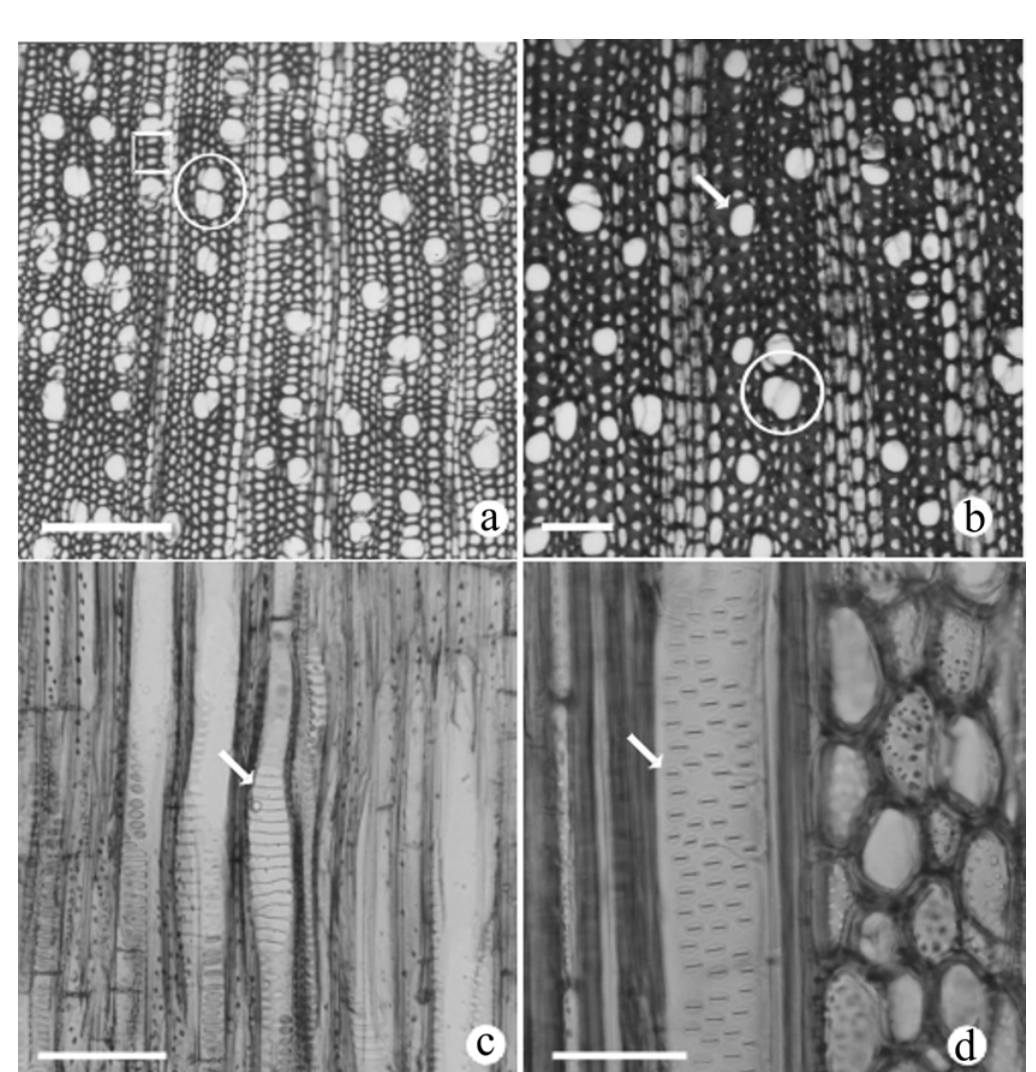
Fig. 2 – Cross and longitudinal sections of the branches of Mollinedia glabra . a. Growth rings distinct (square), difuse-porous, vessels clusters (circle) and solitary of OPS (CS). b. Growth rings indistinct or absent, difuse- porous, vessels paired (circle) and solitary (arrow) of SSCS (CS). c. Scalariform plates (arrow) of OPS (RLS). d. Intervessel opposite (arrow) of OPS (TLS). Bar = 200 μ m (a); 100 μ m (b, c); 50 μ m